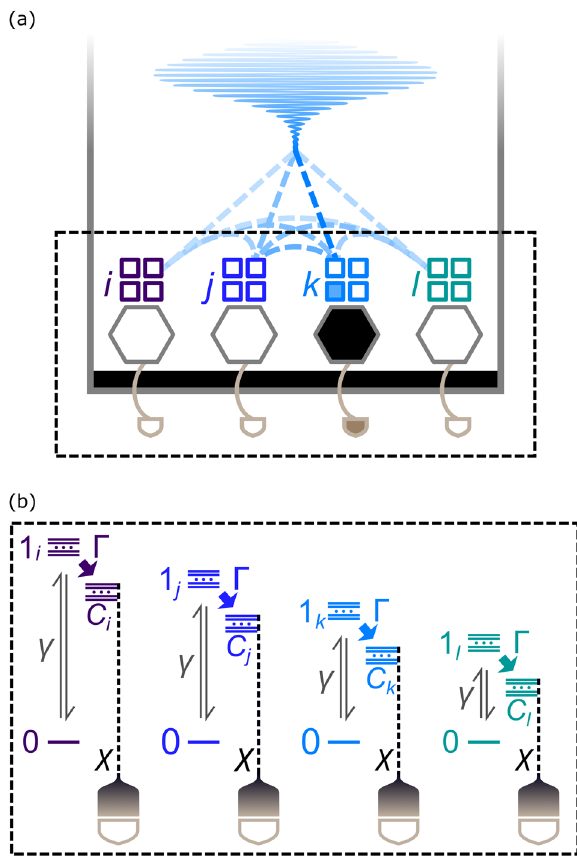
Fig. 2 Internal architecture of the photodetector. a Illustration of the detector structure for the case of N = 4. A photon (blue wavepacket) propagating from top to bottom is guided into a single mode waveguide. The detector comprises absorbing elements (squares) and ampli fi ers (hexagons), which are grouped into subsystems containing multiple absorbing elements that are (near-)degenerate with subsystem-speci fi c transition frequency. The absorbing elements in all subsystems interact with the photon (as indicated by the dashed lines), which is ultimately absorbed by a single element ( fi lled square), modulating the signal in the associated ampli fi er ( fi lled hexagon). b Energy diagram for the detector. The elements are divided into groups characterized by near-degenerate transitions of different energies. Optical excitation is from the ground state 0 to the excited state 1, followed by incoherent decay to dark states C monitored by ampli fi ers; each dark state corresponding to elements of different transition frequency are associated with distinct ampli fi ers allowing for discrimination of the incoming photon frequency. Dots between lines marking energy states are used to indicate that many more states are present than are drawn explicitly. Here Γ is the incoherent transition rate, γ is the optical transition rate, and χ is the measurement